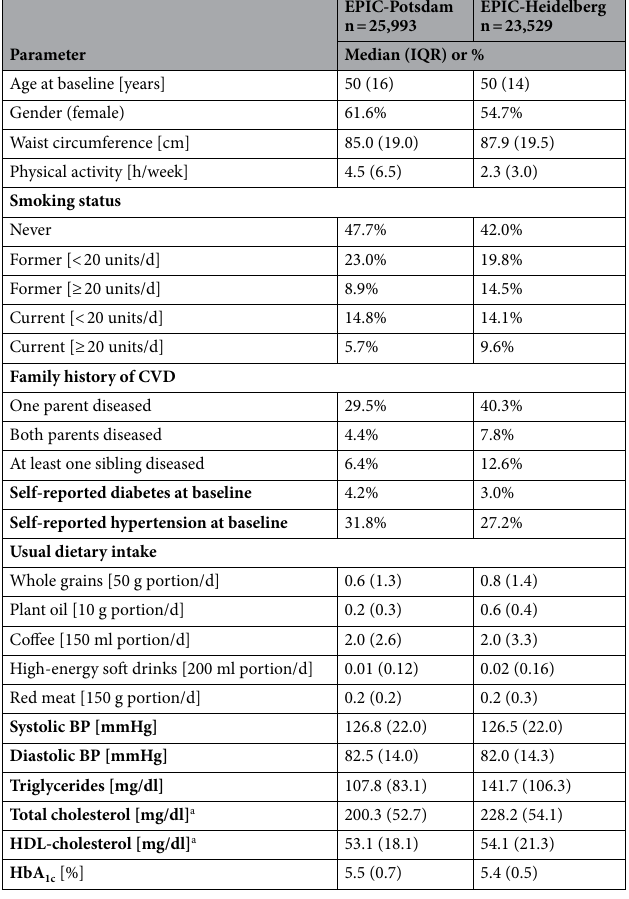
Table 1. Baseline characteristics of the EPIC-Potsdam and EPIC-Heidelberg cohorts. IQR, interquartile range. CVD, cardiovascular disease. BP, blood pressure. HDL, high density lipoprotein. HbA 1c , glycated haemoglobin. a to convert cholesterol to mmol/L, multiply values by